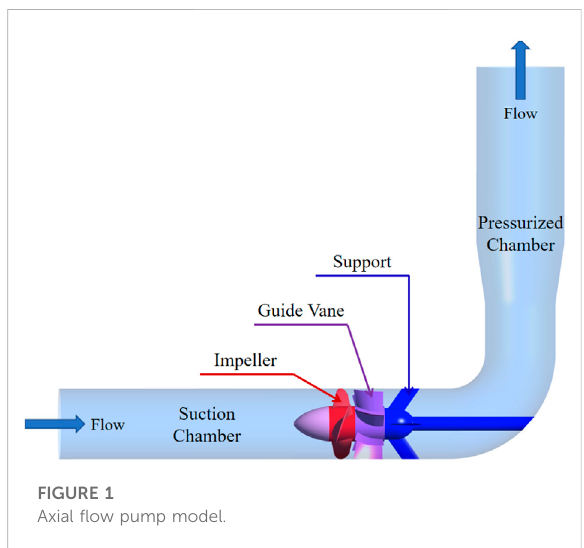
FIGURE 1 Axial fl ow pump